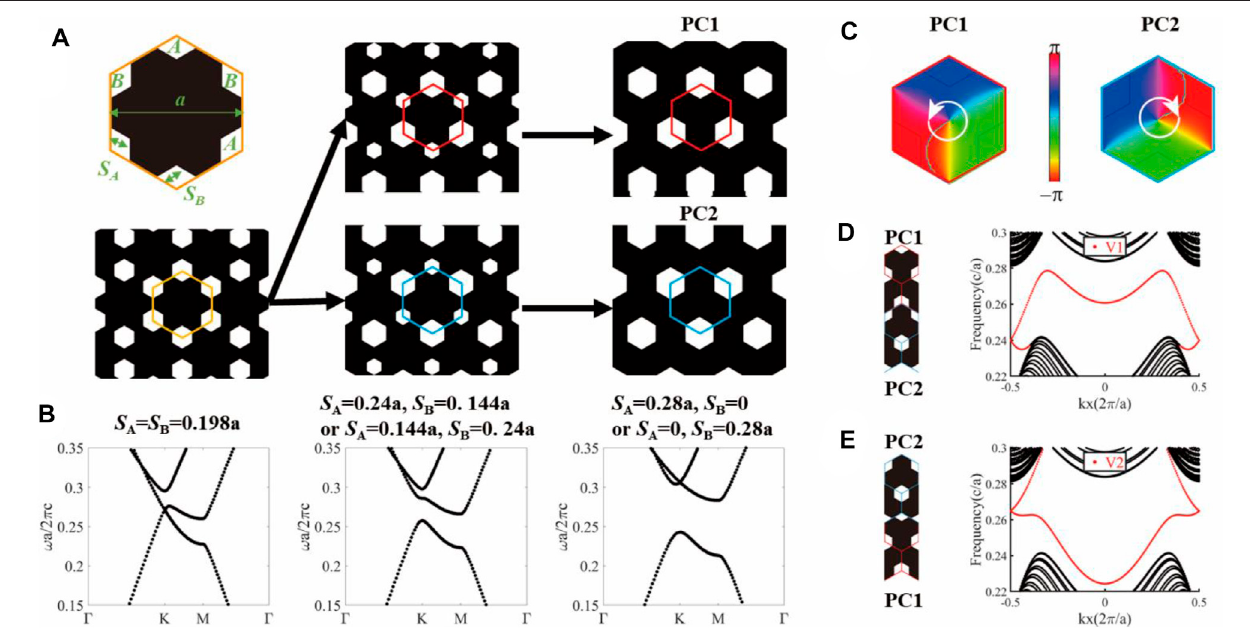
FIGURE1| Designofvalleyphotoniccrystalinahoneycomblattice. (A) Theevolutionofhoneycomb-latticephotoniccrystals(PCs) and (B) thecorrespondingTE- polarized band structures. The unit cell of honeycomb-lattice PC with lattice constant a consists of two hexagon-pro fi le air holes at the corners, where the side length of hole A (or hole B) is S A (or S B ). When the two air holes have equivalent side length that S A = S B = 0.198a (left panel), the TE-polarized photonic bands possess a Dirac conearoundtheKpoint.Thespatialinversion symmetryofhoneycombPCisbrokenwhen S A ≠ S B ,andthusthedegeneratestatesattheKpointareliftedtoopen a common TE band gap. Finally, we have two speci fi c cases, i.e., PC1 with S A = 0 and S B = 0.28 a and PC2 with S A = 0.28 a and S B = 0. (C) Phase distribution of H z eigen fi elds of the fi rst TE bulk band at the K point. For PC1 (or PC2), we can observe that the phase vortex increases counterclockwise (or clockwise) by 2 π around the center of unit cell, indicating the valley Chern index C K (cid:1) − 1/2 (or C K (cid:1) + 1/2). (D,E) Schematics of two types of valley-dependent interfaces and their edge dispersions (labeled as V1 and V2). The red points represent the edge states, while the black points represent bulk states.